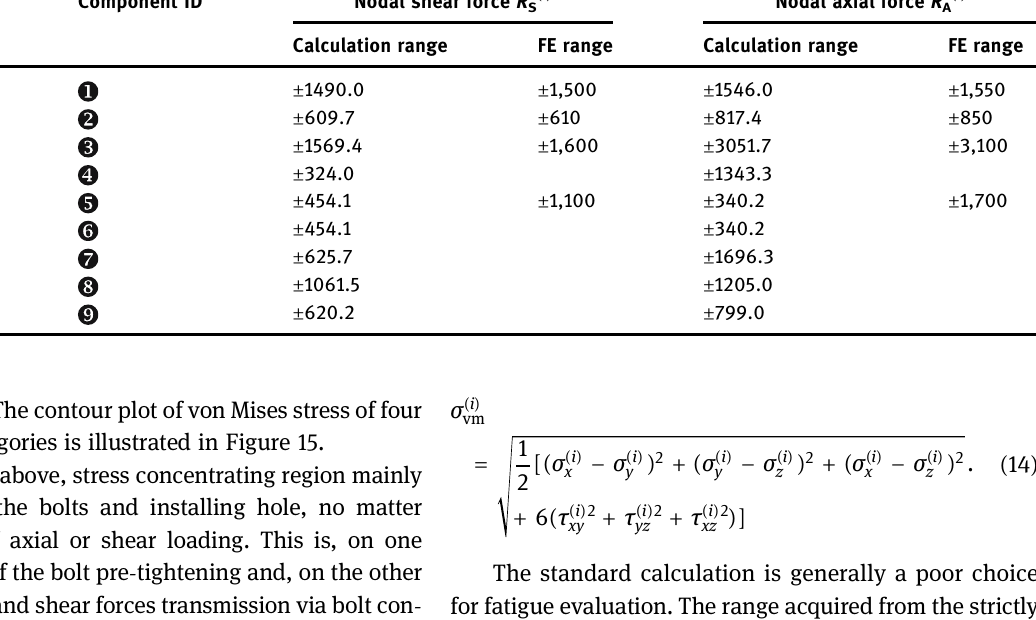
Connection components